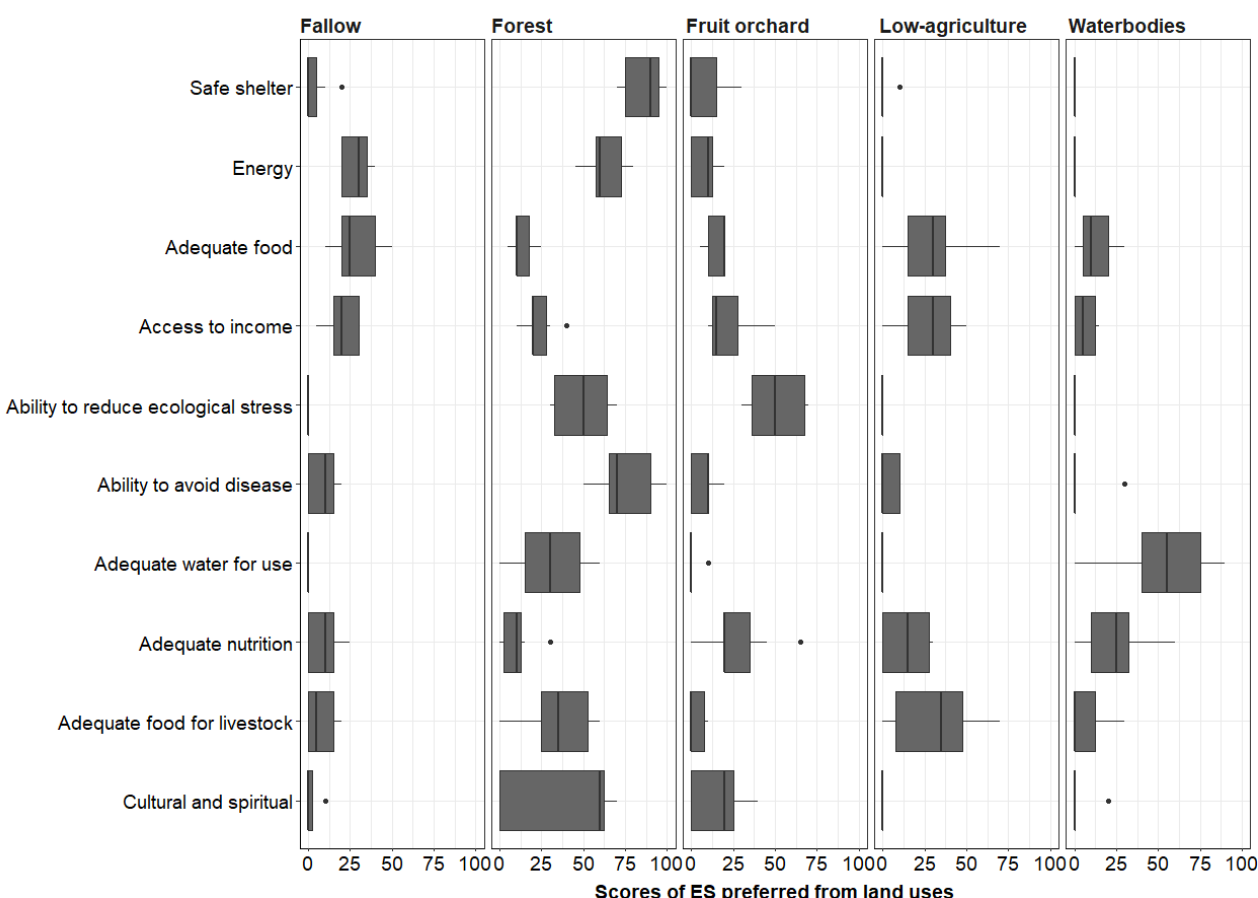
Figure 3. People’s preferences for ecosystem services from different land uses to meet their well- being needs.